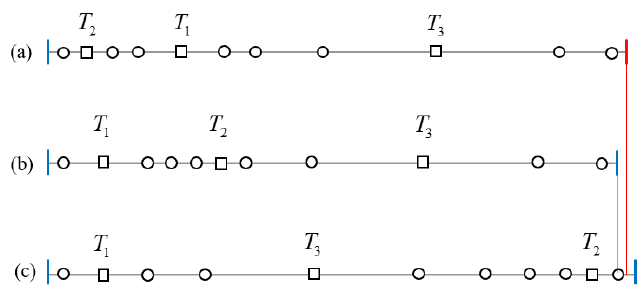
Figure 17. The barrier length’s variation of three optimal BR sensor placement sequences on the heterogeneous barrier (Squares denote transmitters and circulars denote receivers): ( a ) optimal placement sequence: ( RT 2 RRT 1 RRRT 3 RR ) ; ( b ) optimal placement sequence: ( RT 1 RRRT 2 RRT 3 RR ) ; ( c ) optimal placement sequence: ( RT 1 RRT 3 RRRRT 2 R )